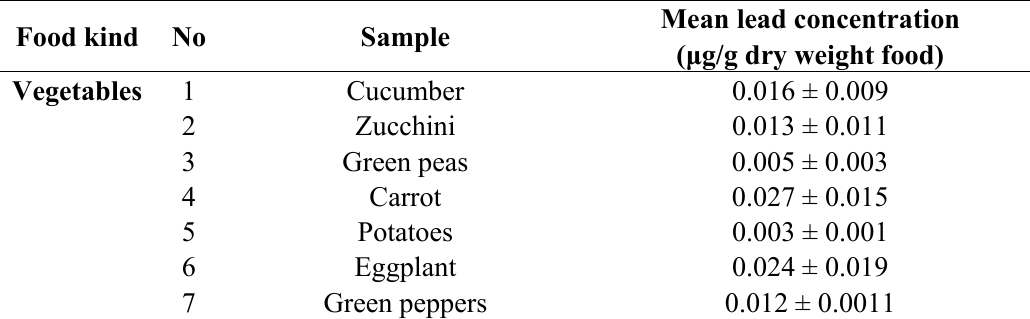
Table 1. Concentration of lead in analyzed food